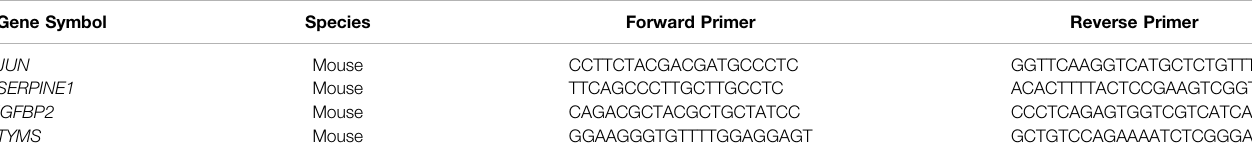
TABLE 2 | Primers used for RT-PCR